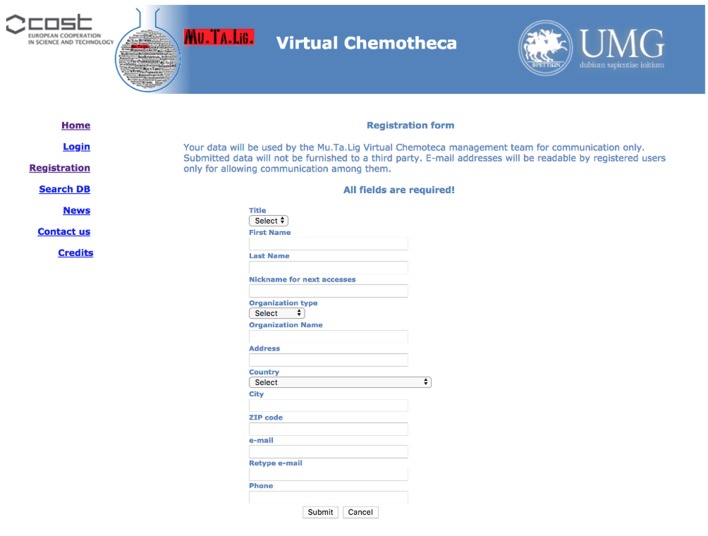
Registration form.